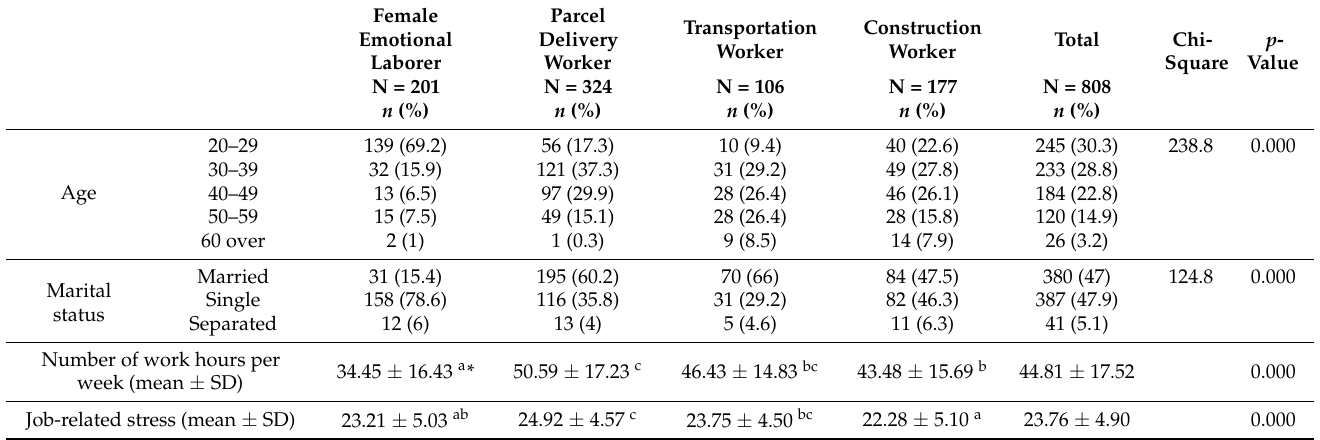
Table 1. Participants’ general